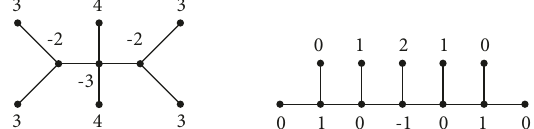
Figure 2: A caterpillar 𝑇 .